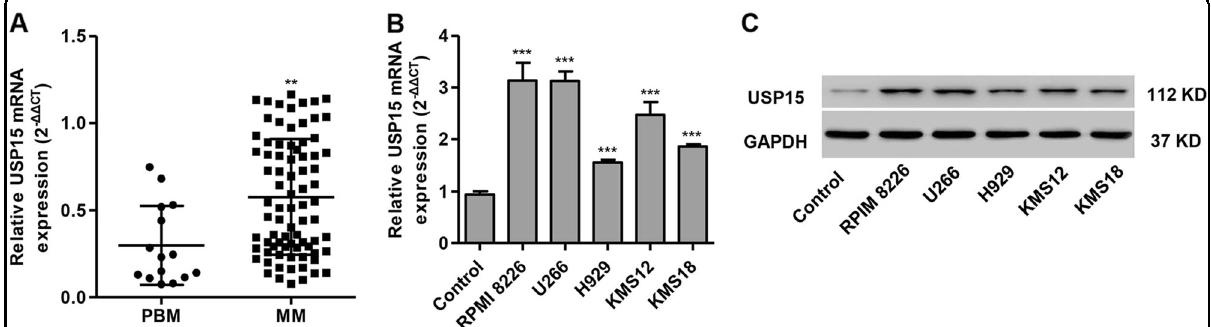
Fig. 1 USP15 expression in MM tissues and cell lines. a The mRNA expression of USP15 in bone marrow samples from 80 patients with multiple myeloma (MM) and 15 patients with proliferative bone marrow (PBM) was measured by Real-time PCR. The expression of USP15 in fi ve different MM cell lines and in control cells, non-cancerous bone marrow-derived plasma cells, was measured by Real-time PCR ( b ) and western blotting ( c ). ** P < 0.01 compared with PBM or